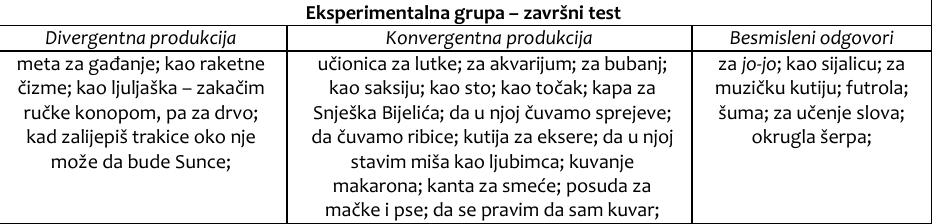
Tabela 4. Odgovori na finalnom testu (eksperimentalna grupa) Eksperimentalna grupa – završni test